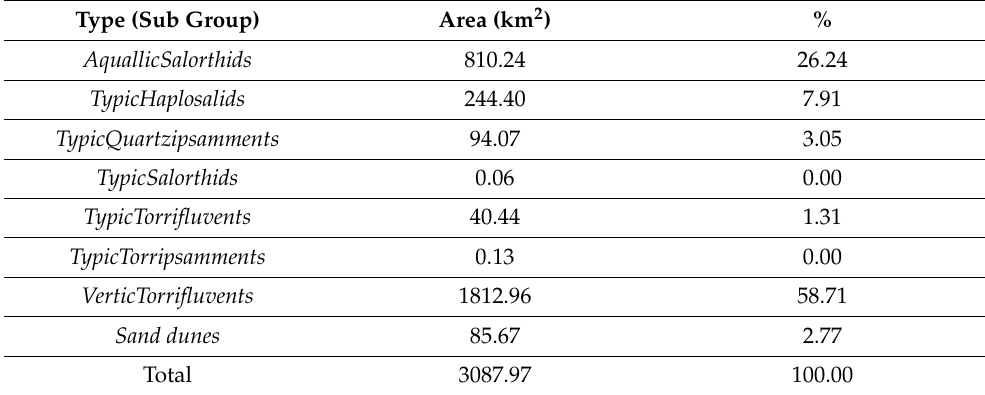
Table 6. Areas and frequencies of soil sub-groups in Kafr El Sheikh Governorate.